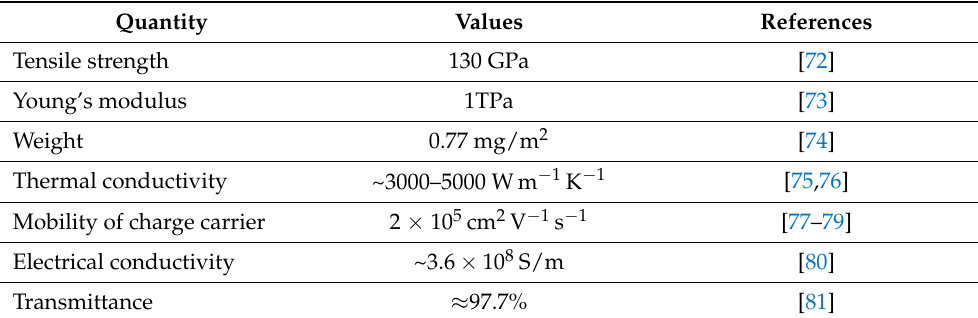
Figure 4. Structure of graphene as a honeycomb lattice of carbon atoms. Table 3. Summary of the basic physical properties of